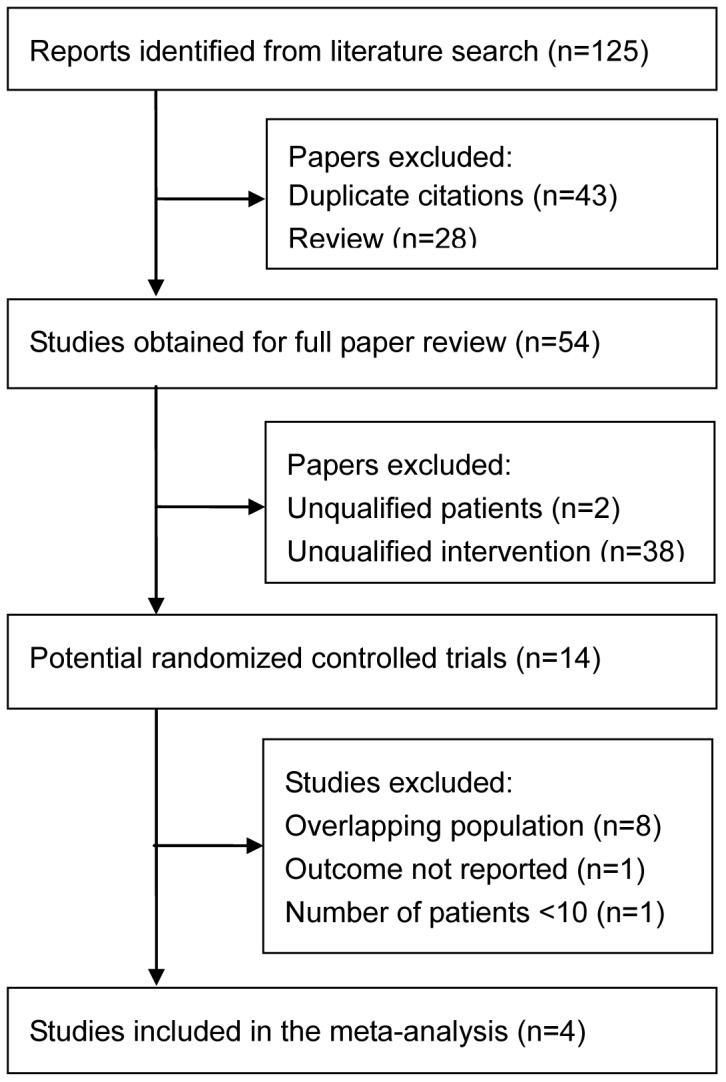
Flowchart of studies included in meta-analysis. RCT, randomized controlled trial.